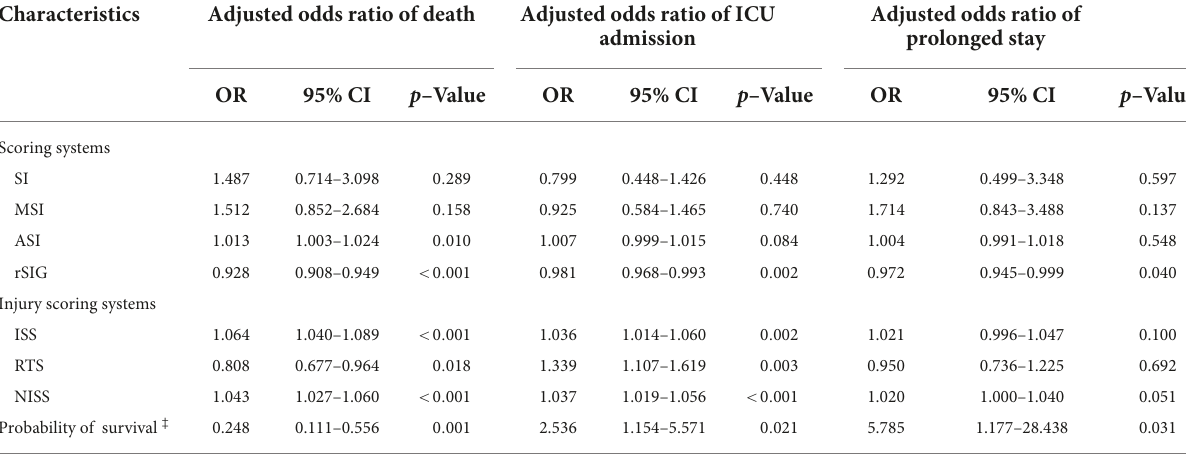
TABLE 3 Clinical outcome prediction by multivariable logistic